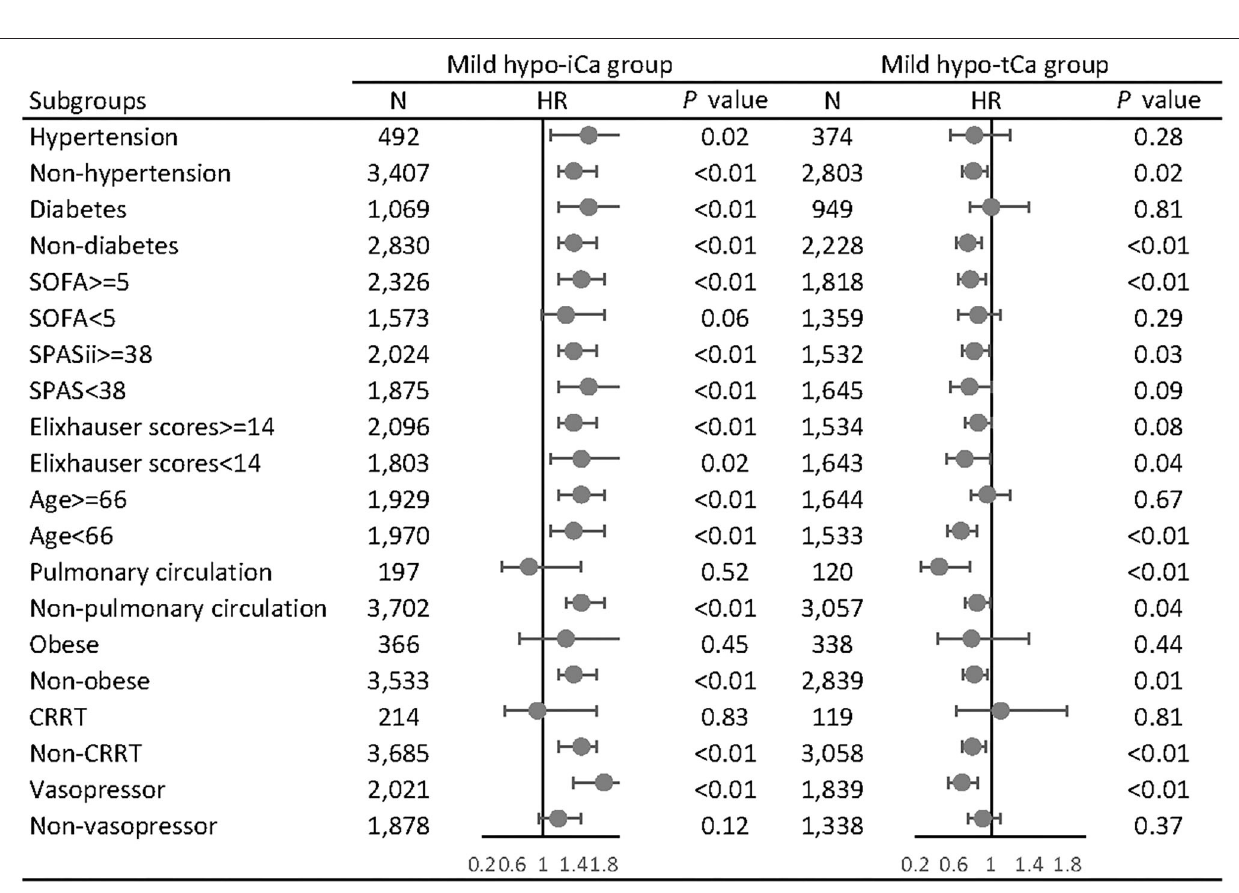
Frontiers in Cardiovascular Medicine |